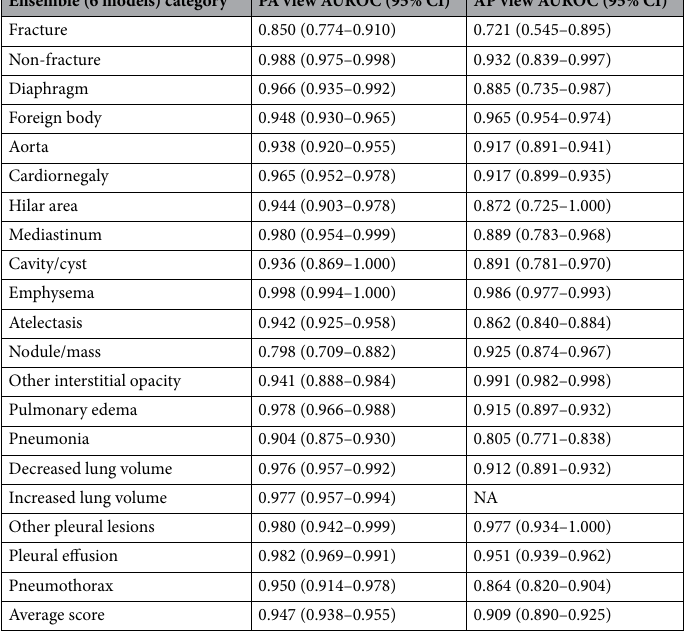
Table 1. AUROCs derived from application of the final model to the test set. Non-fracture refers to non-fracture bone abnormality. Diaphragm, Aorta, Hilar area, and Mediastinum refer to diaphragmatic abnormality, aortic abnormality, hilar abnormality, and mediastinal abnormality, respectively. As there were no cases with increased lung volume in the test set, the AUROC for this label could not be